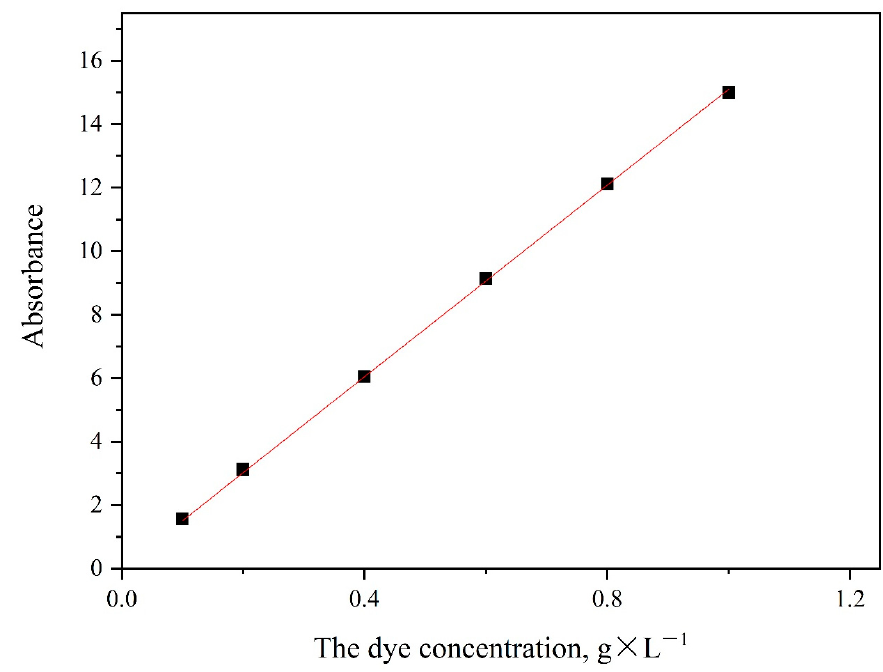
Figure 7. The standard working curve of neutral red G. Polymers 2022 , 14 , x FOR PEER REVIEW